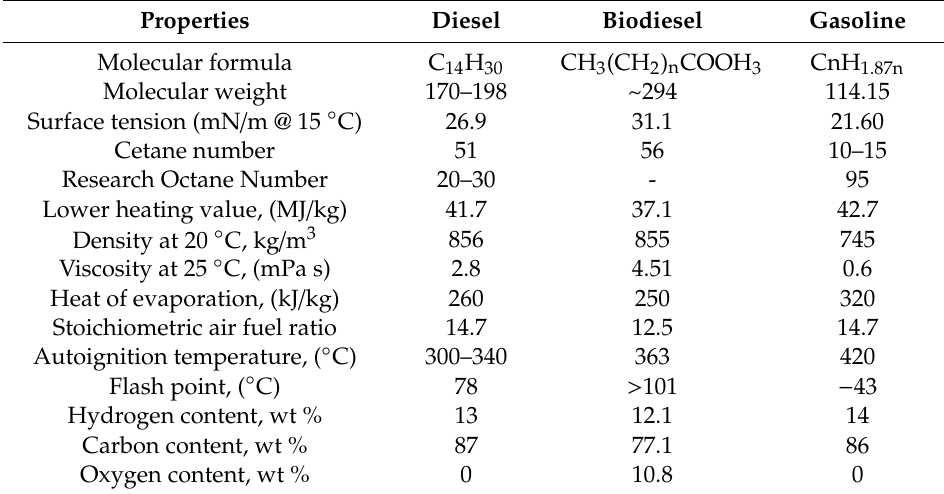
Figure 3. Doses of fuel for various energetic fraction used during the tests, ( a ) blend, ( b ) dual fuel. Table 2. Fuels’ properties